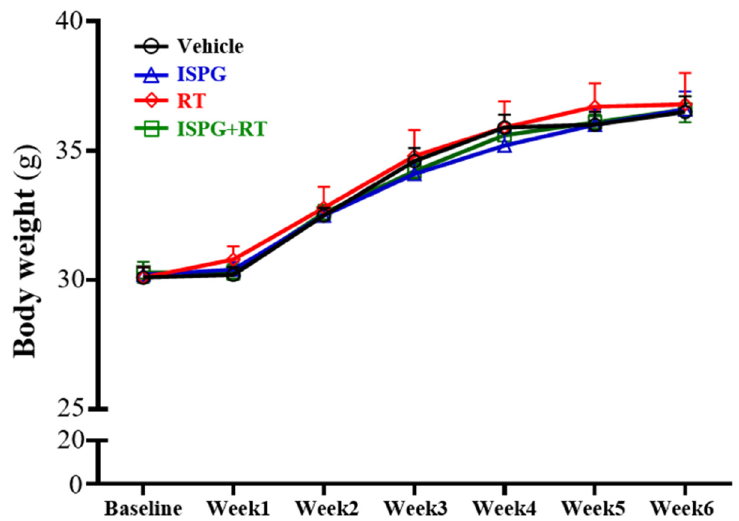
Figure 2. The effect of ISPG and resistance training on growth curve. Data were mean ± SEM for n = 8 mice per group. Table 2. General characteristics of the experimental groups.